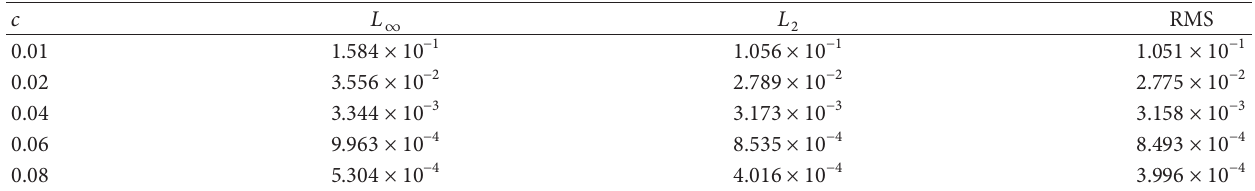
Table 6: Numerical errors using IMQ represented with different parameter 𝑐 at time 𝑡 = 1 , where 𝑑𝑥 = 0.01 , 𝑑𝑡 = 0.001 , and 𝜃 = 1/2 .